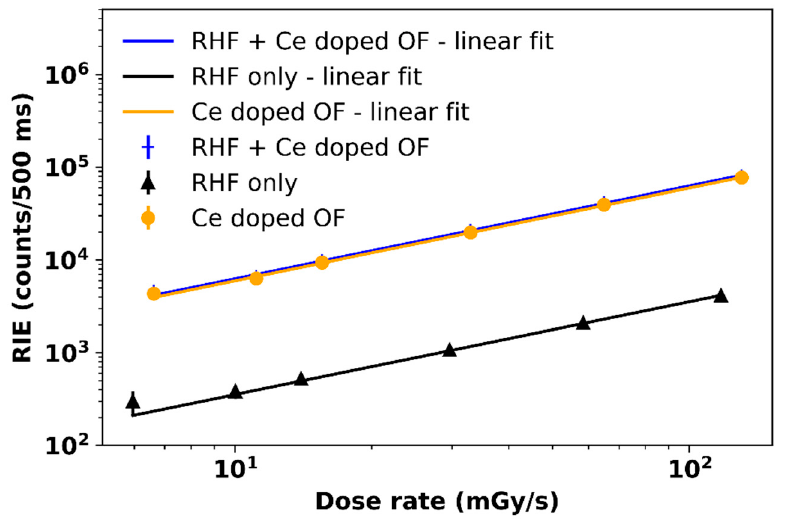
Figure 9. Linear dependence of RIE with dose rate for both optical fibers irradiated successively at different dose rates.